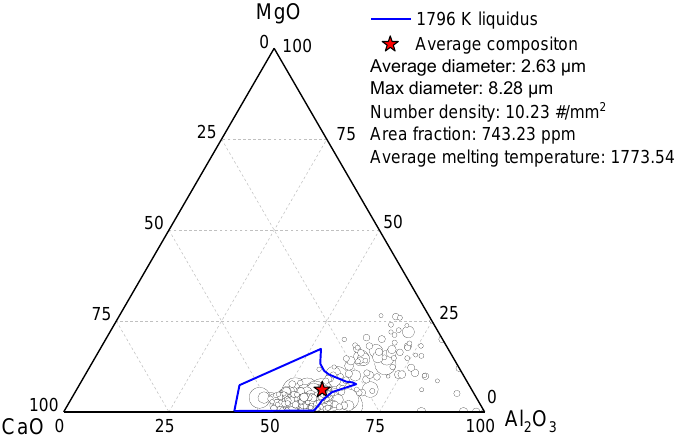
Figure 5. Composition distribution of inclusions in the molten steel of the CC tundish.